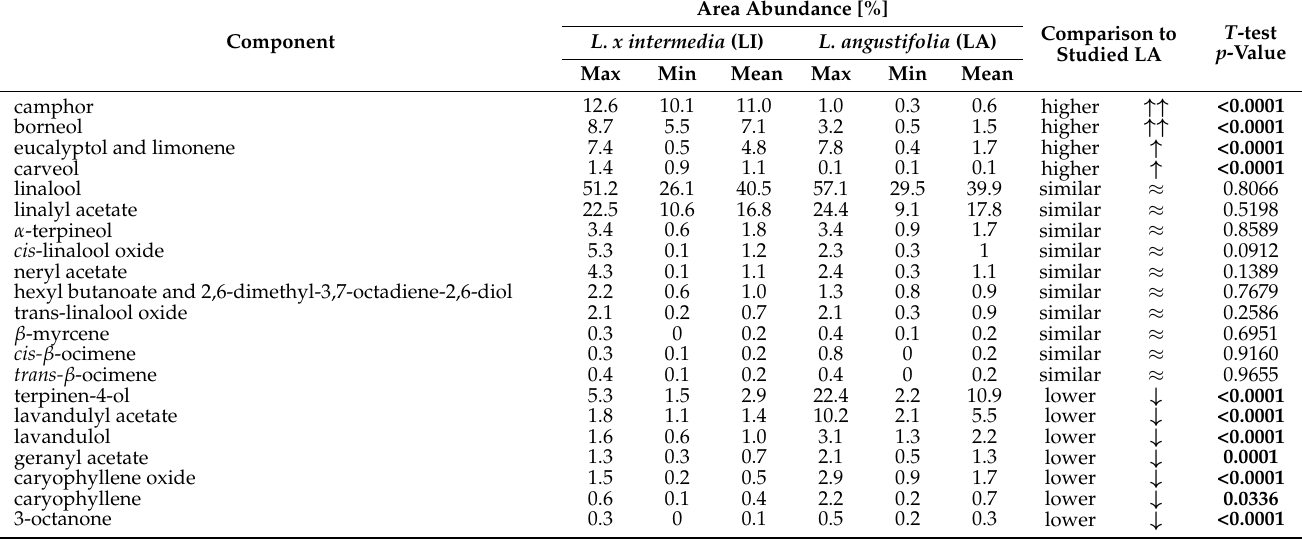
Table 7. Comparative table of essential oils from the studied new Ukrainian cultivars of lavandin with the new Ukrainian cultivars of L. angustifolia grown on the same plots. The table includes regulated components and/or some main component identified in tested samples. The marked p values (in bold) are statistically